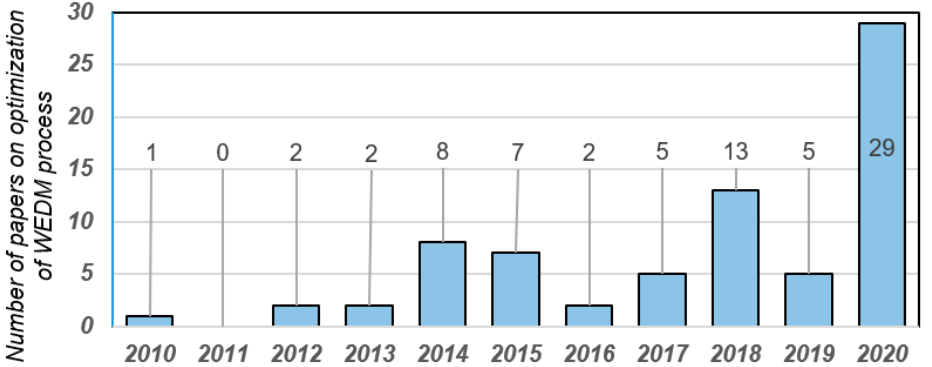
Figure 10. Evolution of the number of scientific papers related to the WEDM process in the ScienceDirect database.